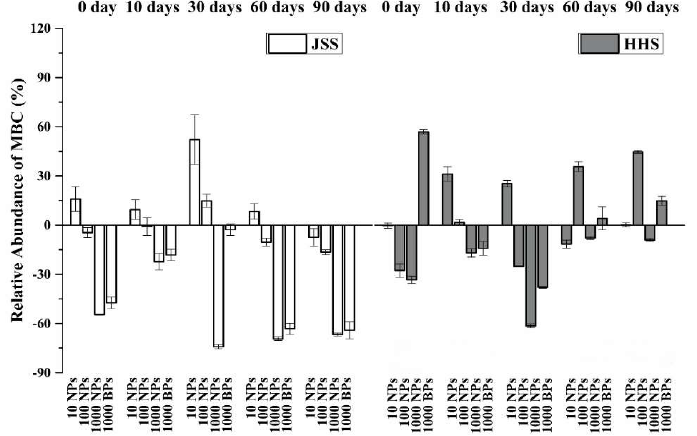
Figure 7. The relative abundance of microbial biomass carbon (MBC) in two tested soils (compared to the control). White: Jinshan Soil (JSS); Gray: Heihe Soil (HHS). Error bars indicate the standard deviation of the mean ( n =